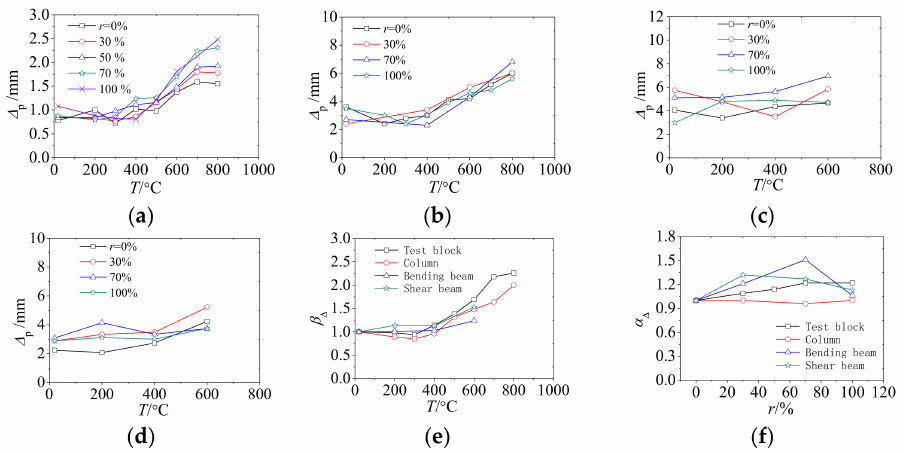
Figure 15. Deformation corresponding to the peak load. ( a ) rectangular prisms specimens; ( b ) columns; ( c ) bending beams; ( d ) shear beams; ( e ) The influence of temperature; ( f ) The influence of replacement